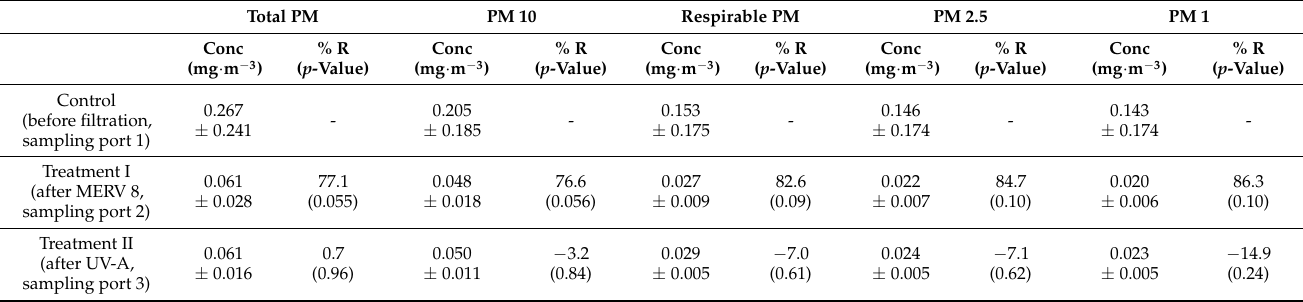
Table 2. Particulate matter removal performance of the MERV 8 (Treatment I) and UV-A photocatalysis (Treatment II) in mitigating PM (the ‘midpoint’ scenario).